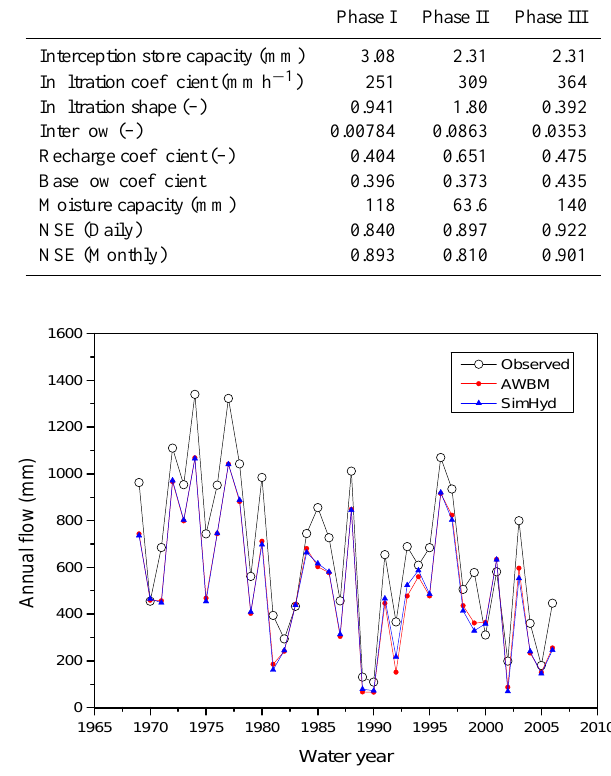
Figure 2. Observed and modelled annual flows using two concep- tual hydrological models for the Rimbaud